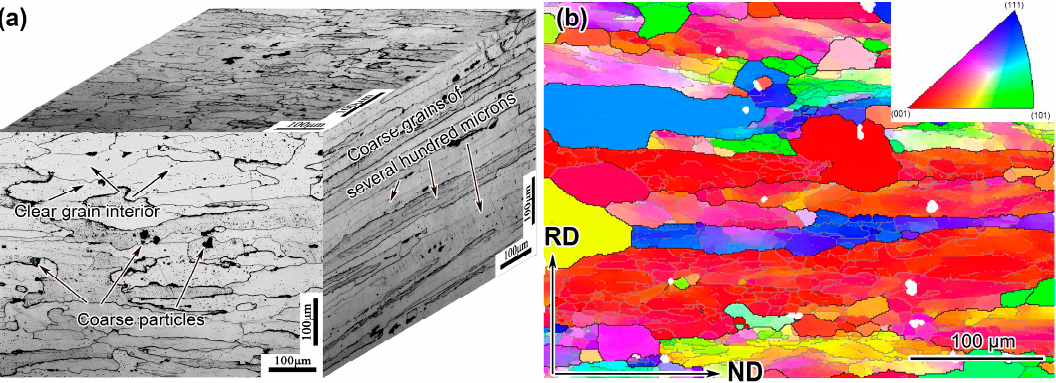
Figure 2. 3D-OM ( a ) and EBSD ( b ) of SQ-7055.